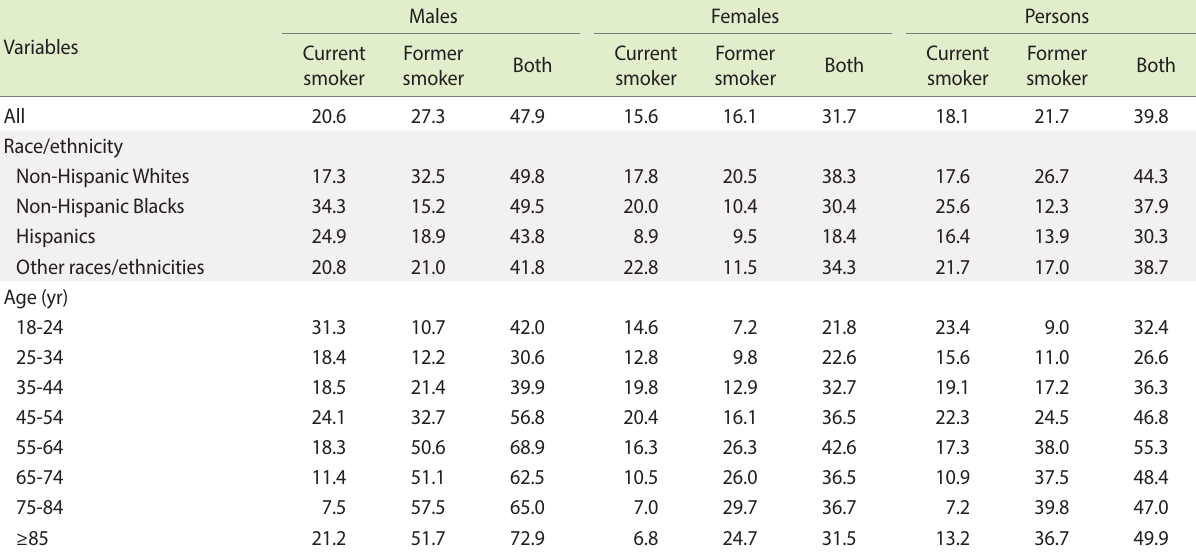
Table 2. Prevalence (%) of tobacco smoking 1 in Texans aged ≥18 years in 2006, overall and by race/ethnicity and age group Variables